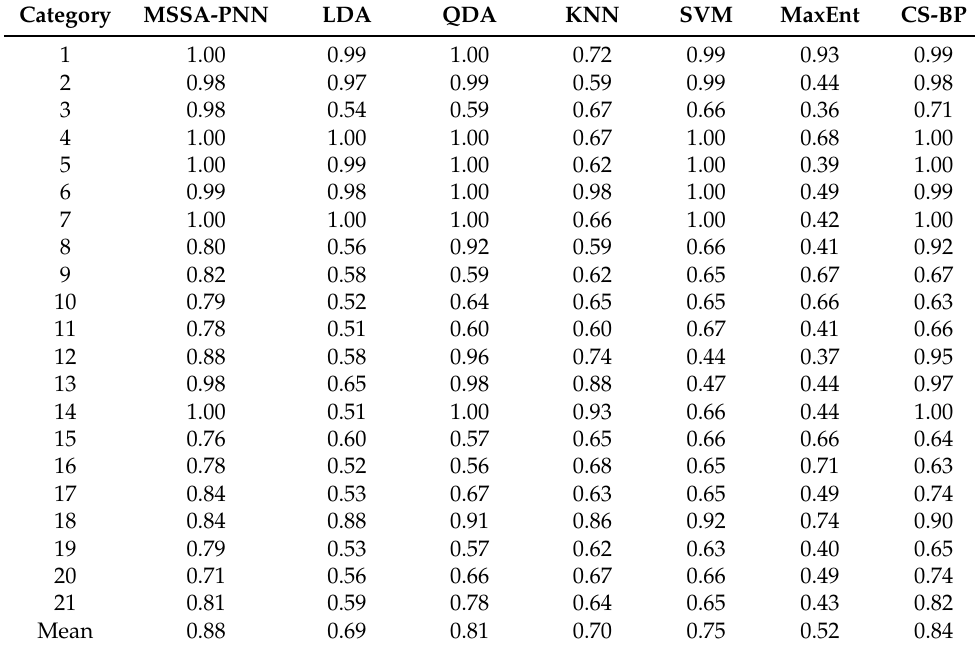
Table 10. The accuracy of MSSA-PNN and other classification models.